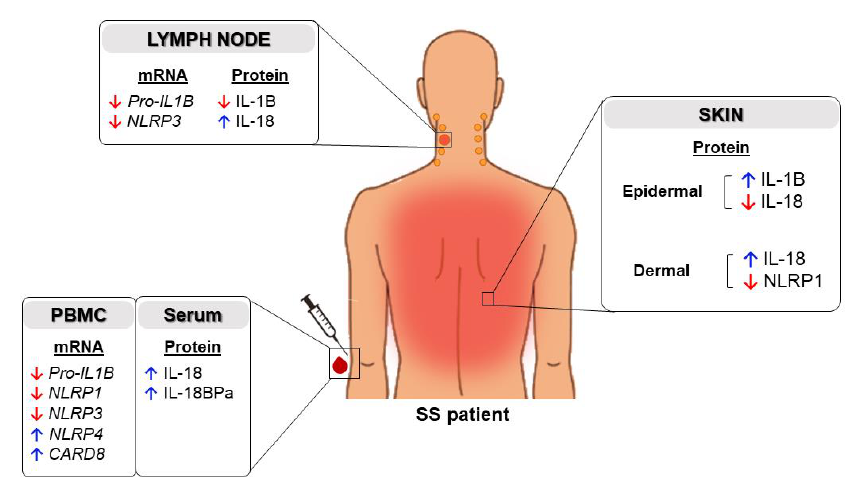
Figure 6. Imbalanced expression of IL-1B and IL-18, as well as their associated regulators of inflam- mation, in Sézary syndrome.